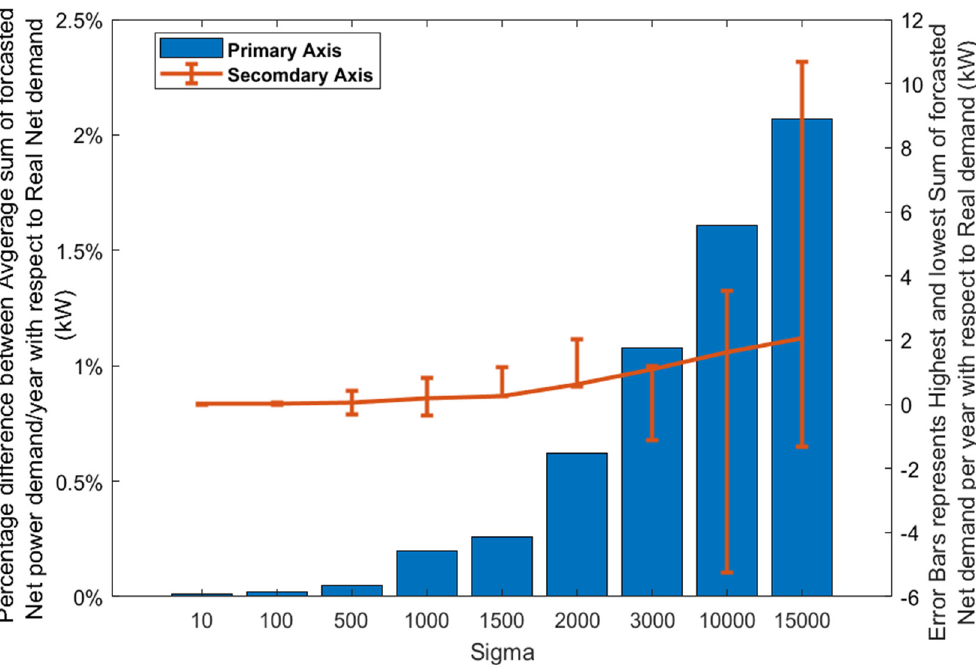
Figure 6. Average sum of forecasted demand with respect to real demand per year.